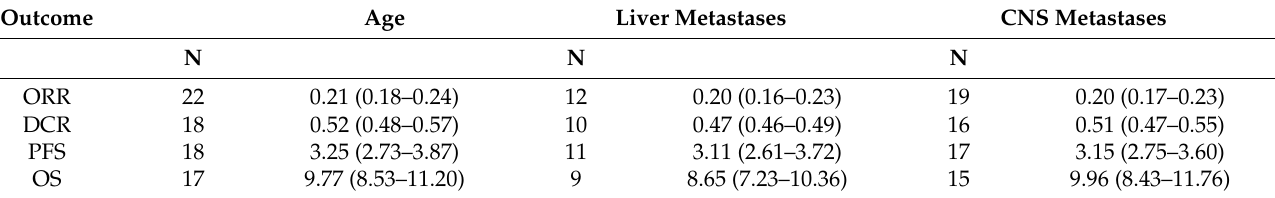
Table 3. Estimated pooled ORR, DCR, progression-free survival (PFS) and overall survival (OS) by adjusting for age and CNS or liver metastases.